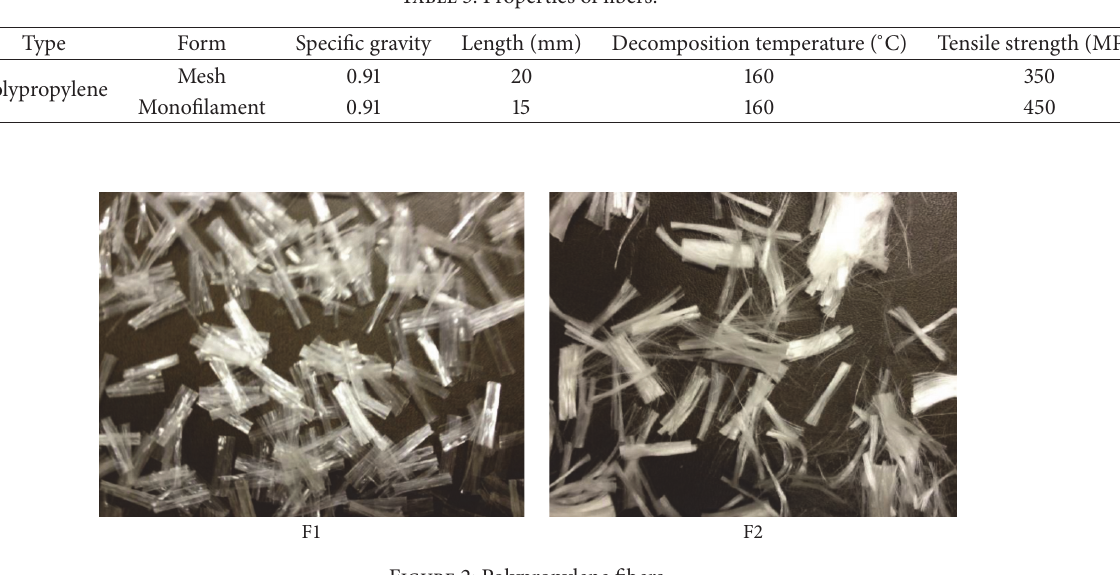
Table 3: Properties of fibers.